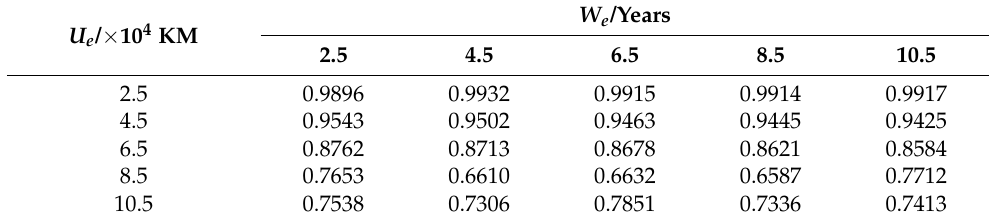
Table 8. The system